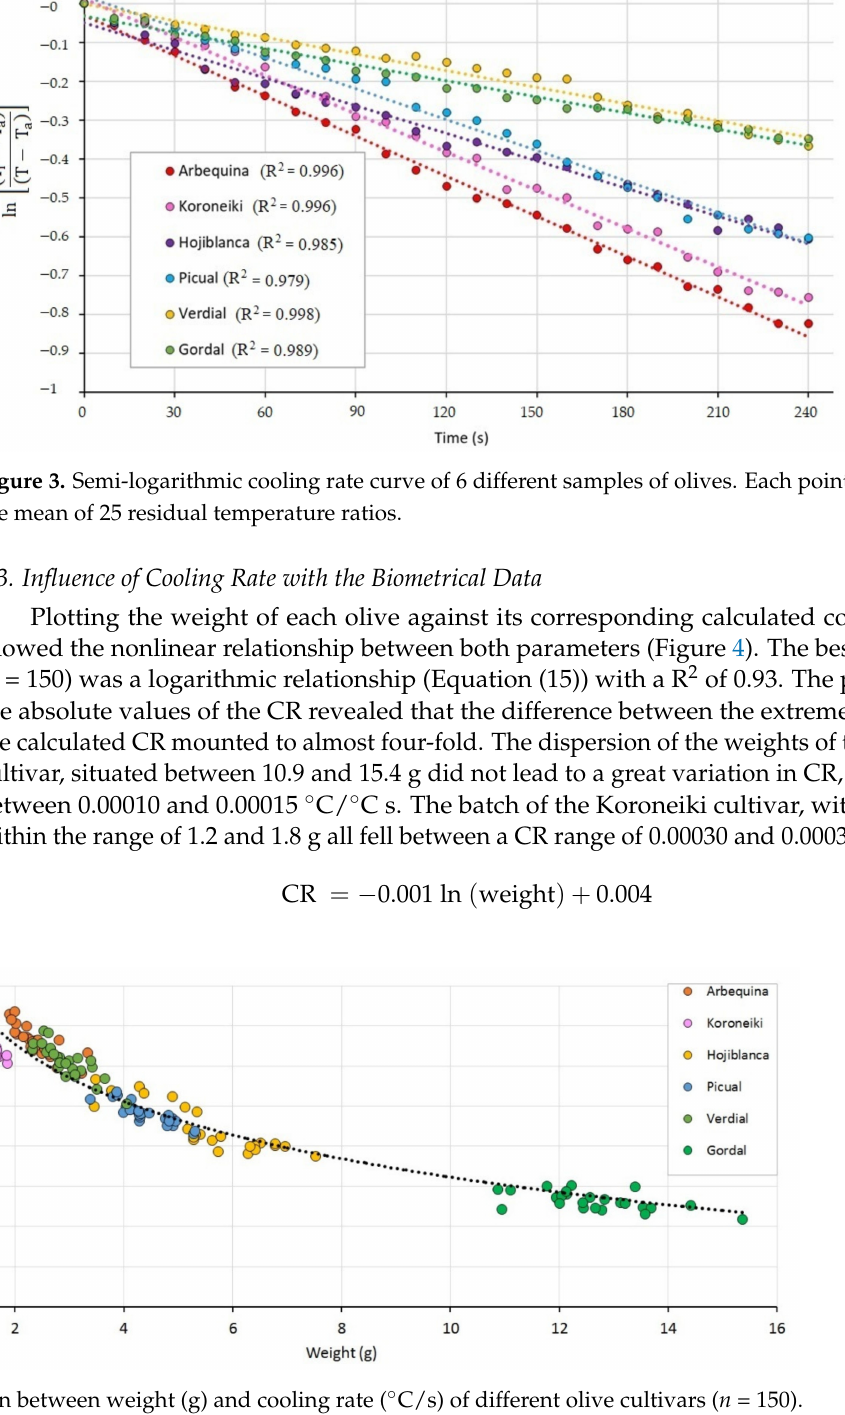
Figure 4. Correlation between weight (g) and cooling rate ( ◦ C/s) of different olive cultivars ( n =